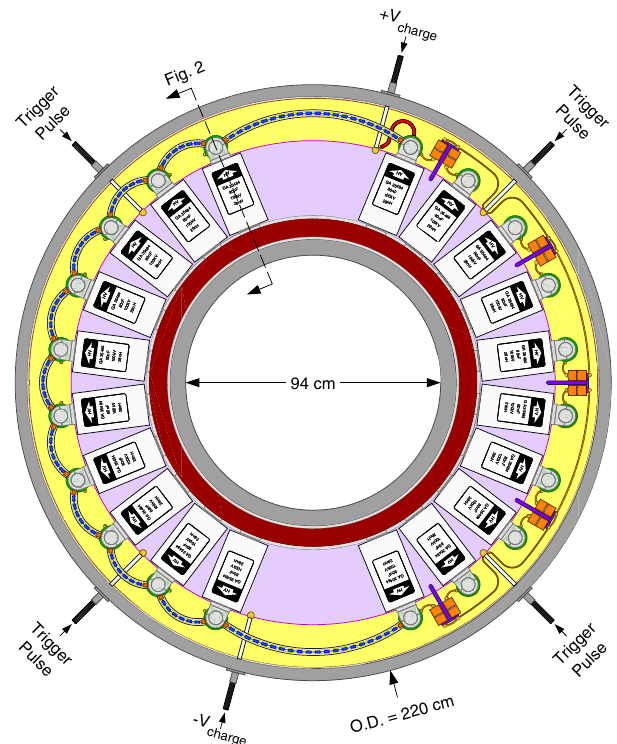
FIG. 1. Top-down illustration of the 100-GW “ Z-Next ” LTD with top lid and insulator removed. The right half of the illustration shows internal trigger circuitry with capacitive cou- pling (charging circuitry not shown), details are given in Fig. 5. The rest of the illustration shows details of the charging circuit (internal trigger circuitry not shown) that is described in Sec. II A. Fasteners and seals are omitted from this illustration. Component materials follow the legends shown in Figs. 2 and 5.